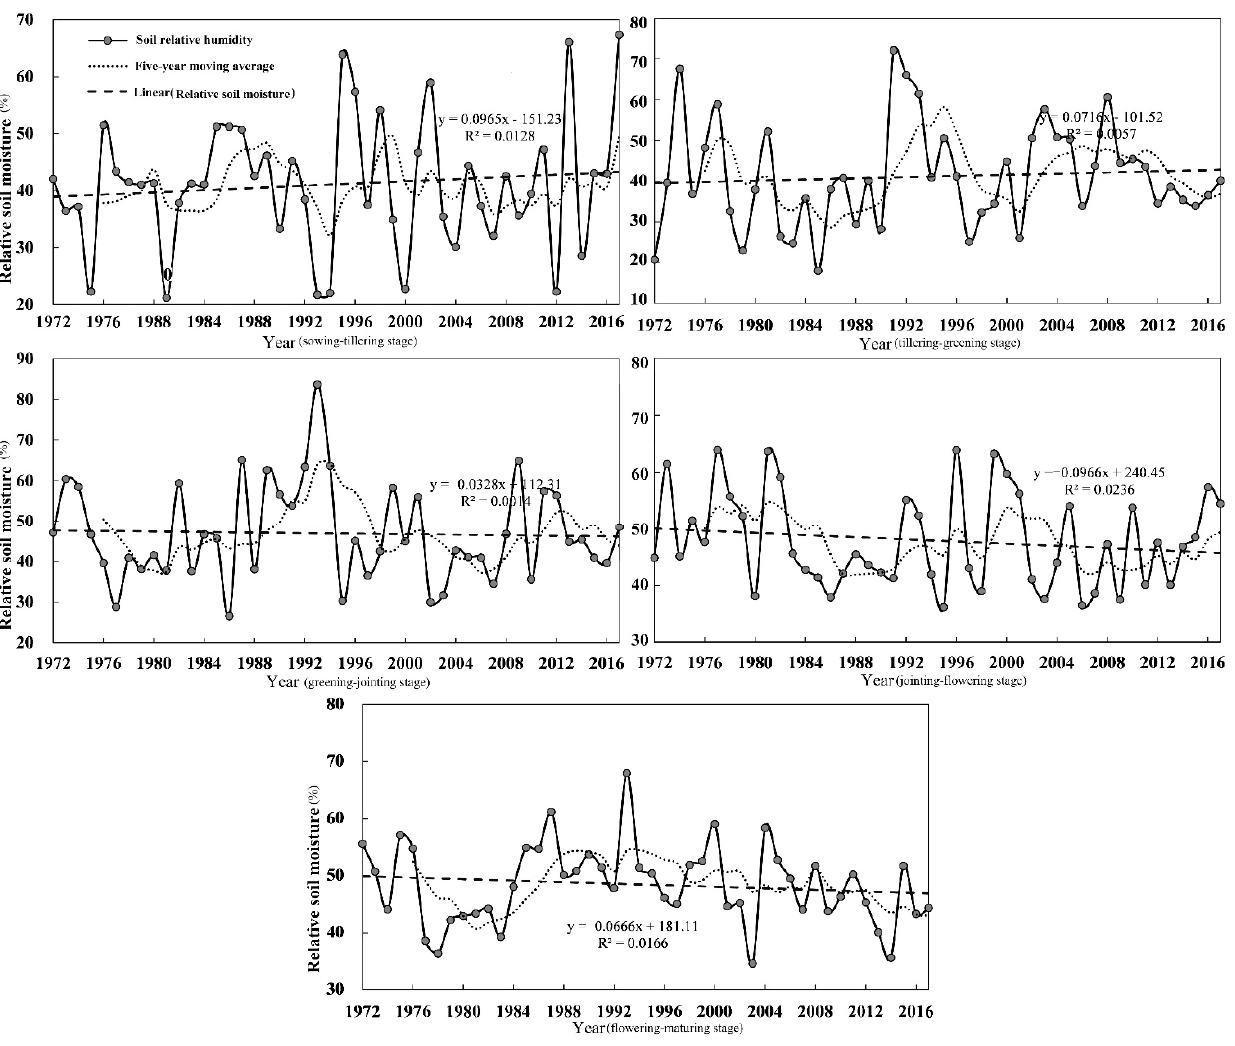
Figure 6. Variation tendency of annual relative humidity in winter wheat.